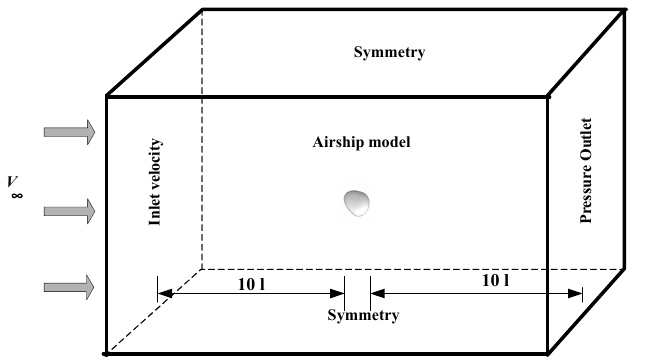
Figure 3. The computational domain of the airship model with the boundary conditions as inlet velocity, pressure outlet, and symmetry.